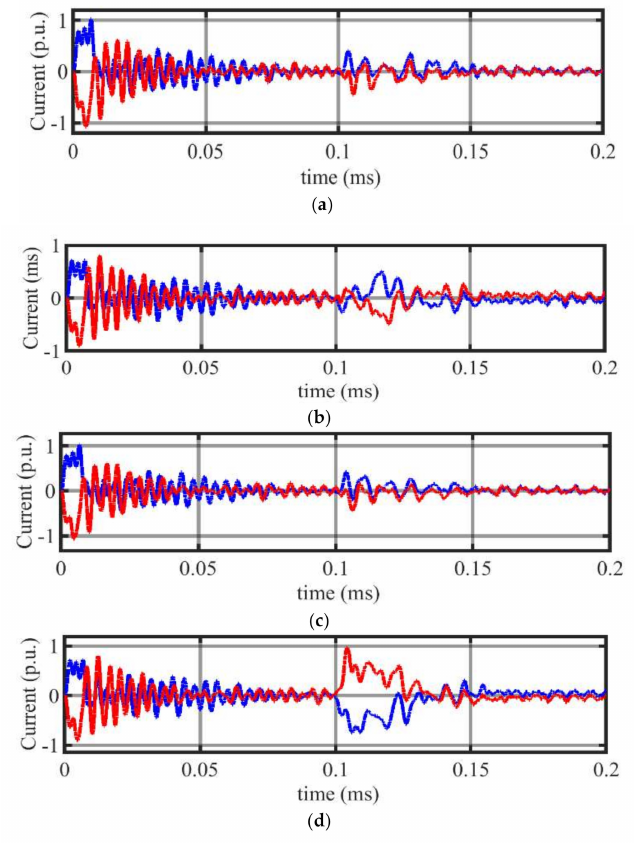
Figure 13. DC currents measured at ( a ) RS-I, ( b ) IS-I, ( c ) RS-II, and ( d ) IS-II under normal condition.